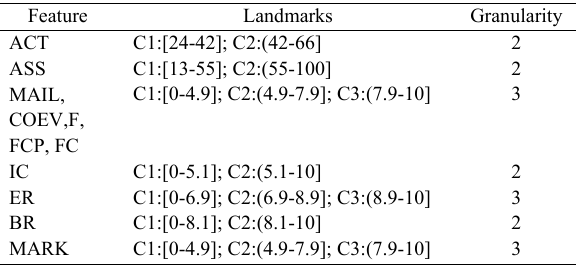
Table 6. Fuzzification parameters defined by